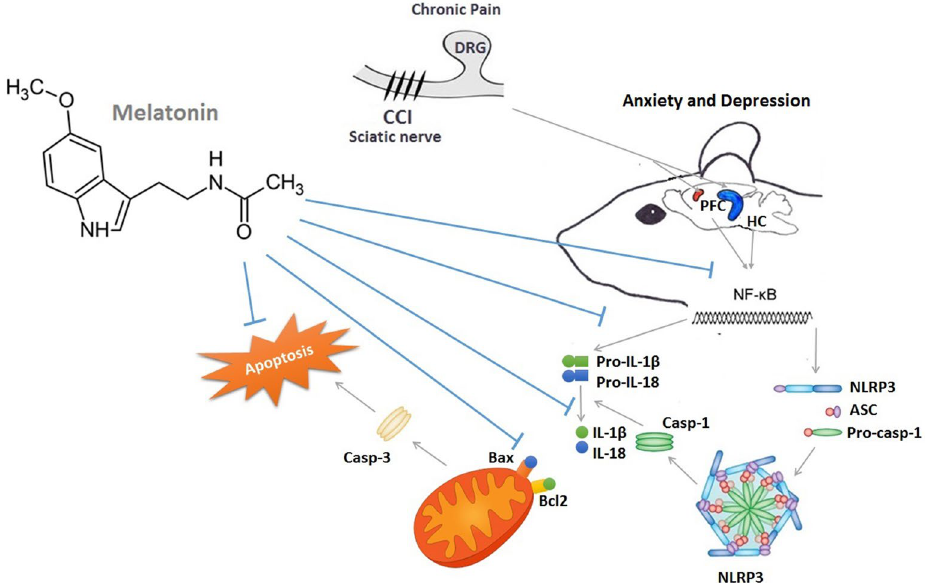
Figure 7. The schematic summary of the study. Exposure of animals to chronic NP activated the NF-κB/ NLRP3 axis in the HC and PFC of CCI-induced animals. Subsequently, the levels of cytokines (IL-1β and IL-18) enhanced in the HC and PFC in the CCI animals. Cytokines dysregulated the protein levels of bax and Bcl2 and resulted in apoptosis in the HC and PFC. MLT administration attenuated the above